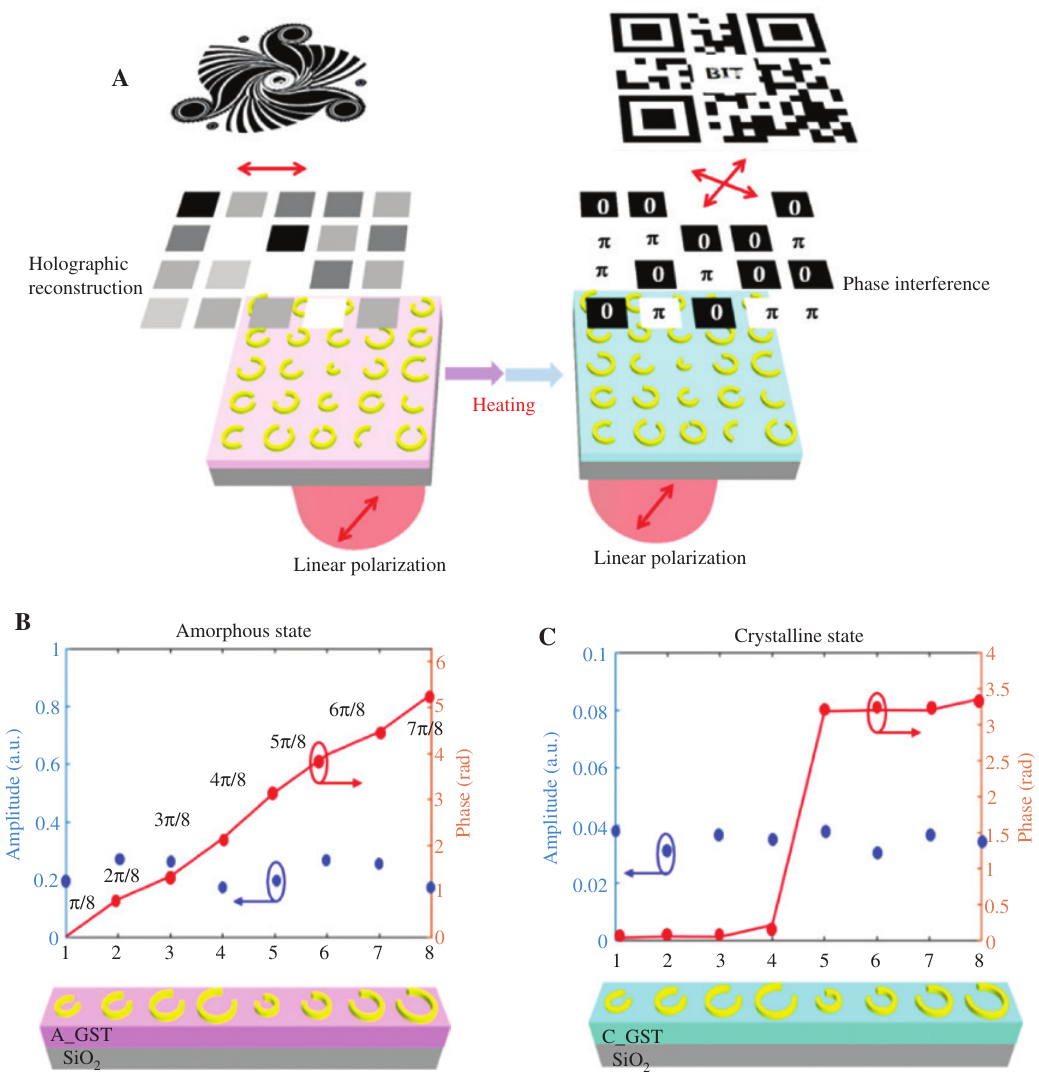
Figure 4: Schematic of double functionalities using the simultaneous phase modulation and interference strategy. (A) Hybrid encryption strategy. Continuous phase modulation under amorphous state is converted to binary phase under crystalline state. (B, C) Amplitude and phase of the selected SRR antennas under amorphous and crystalline